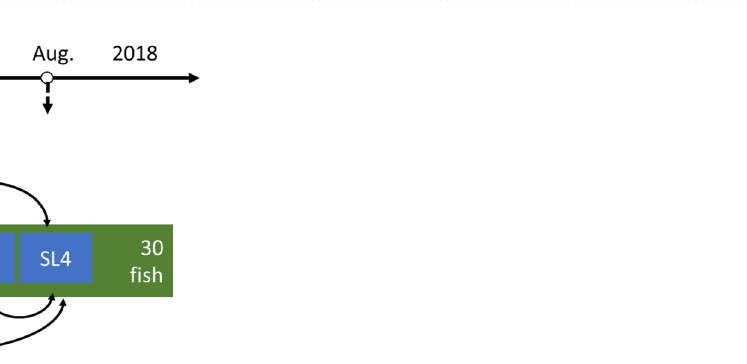
Figure 2. Example of images from data collection. Left—tent data, middle—aquarium data SL1, right— aquarium data SL3. Middle and right images show the different illumination conditions for data collection.